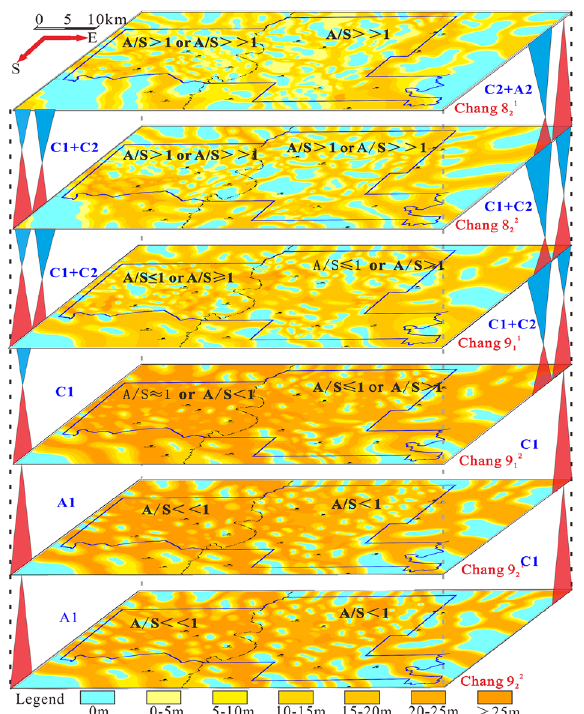
Figure 10. Sand body distribution responses to the dynamic process of sequence